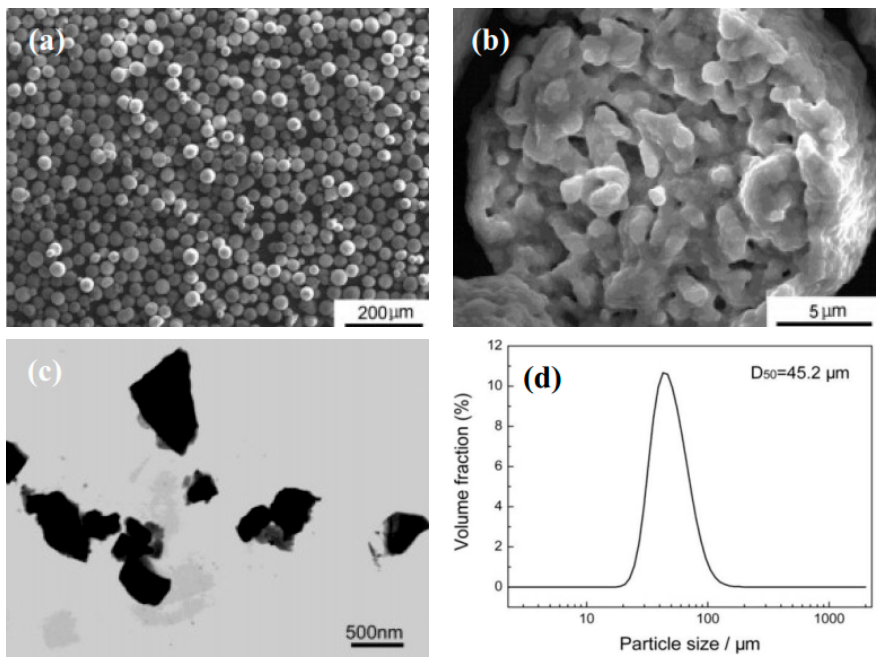
Figure 1. Morphology, grain size and size distribution of YSZ powders: ( a ) External morphology; ( b ) Internal morphology; ( c ) Size of the crushed particles; and ( d ) Size distribution. Table 1. Spraying process parameters for the fifteen kinds of coatings [26].